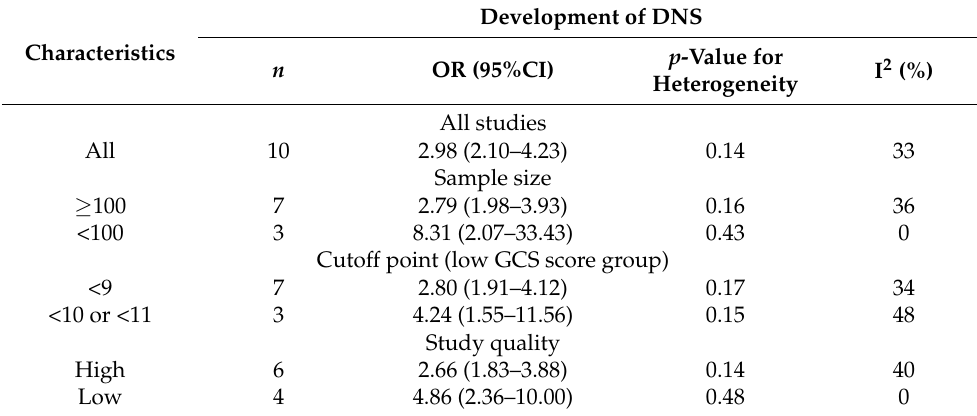
Figure 2. Forest plot for the effect of initial low Glasgow Coma Scale and occurrence of delayed neurological sequelae in carbon monoxide poisoning [1,6,9,17,19,25,30–33]. Table 2. Subgroup analysis for occurrence of delayed neurologic